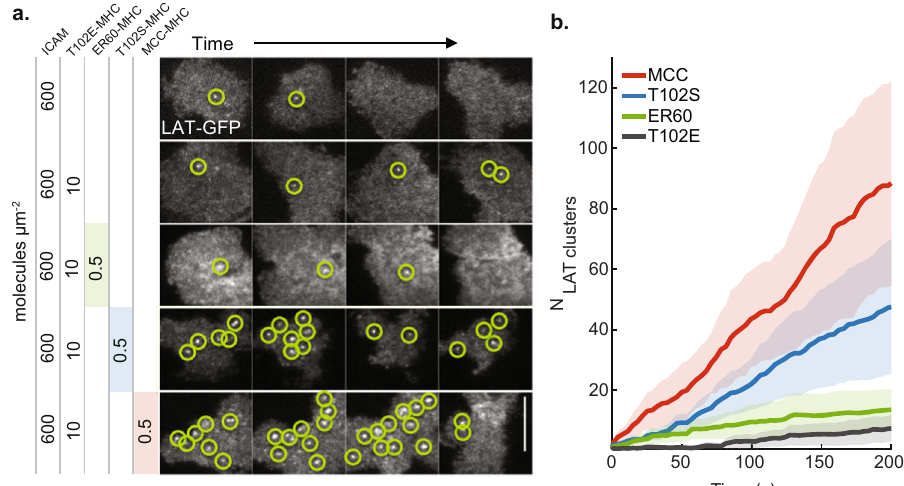
Fig. 5 | The number of LAT condensates correlates with ligand potency. a TIRF images over time of primary mouse T cells deposited onto supported membranes containing 600molecules μ m − 2 ICAM-1 and one of four distinct peptides at the indicated concentrations: MCC(Atto647), T102S(Atto647), ER60(Atto647), or T102E. b cumulative time-series for the number of distinct LAT condensates